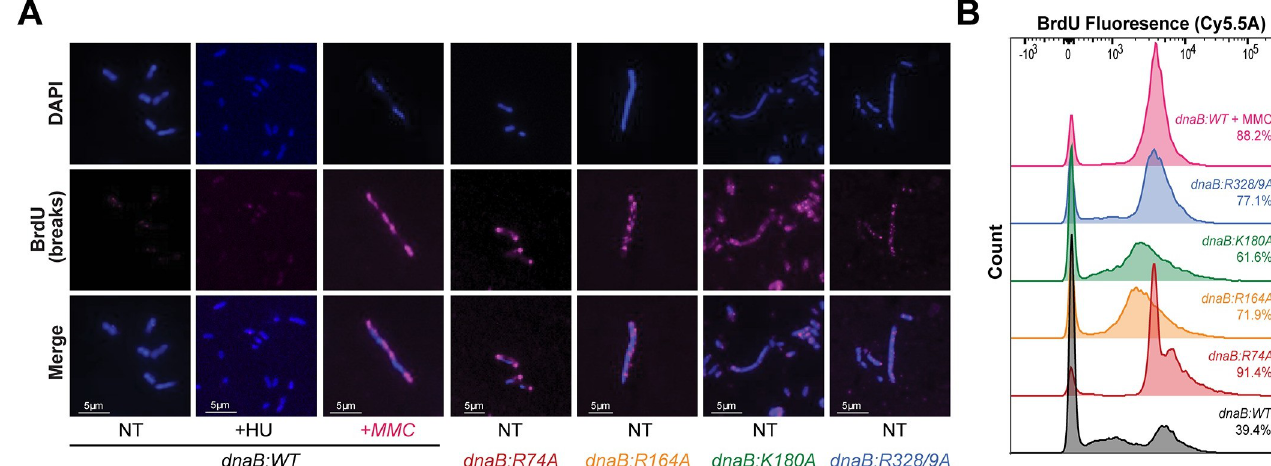
Fig 8. dnaB : mut have increased DNA damage under normal conditions. (A) Exponential growth cells were probed for DNA breaks by a TUNEL assay. Blue (DAPI) represents DNA staining, and pink (BrdU) represents tagged DNA breaks. NT–nontreated; +HU–treated with 10 mM HU; +MMC–treated with 0.01 μ g/mL MMC. Images shown are representative of the population observed. The fraction of BrdU labeled cells was (B) measured and quantified by flow cytometry (FACS), utilizing the same exponential growth cultures as the microscopy images. BrdU-negative and positive populations were gated at 10 2 and the percentages are indicated on the plot; data is from n = 10,000